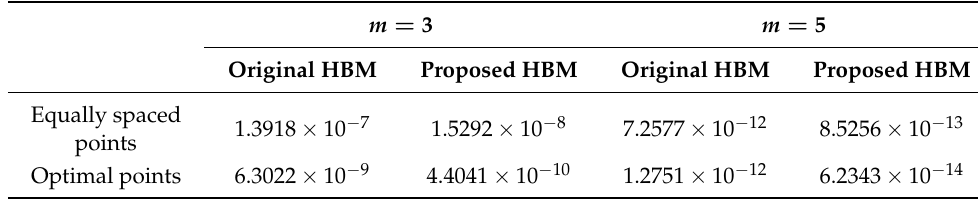
Table 4. Maximum errors for Example 2 using different choices of intra-step